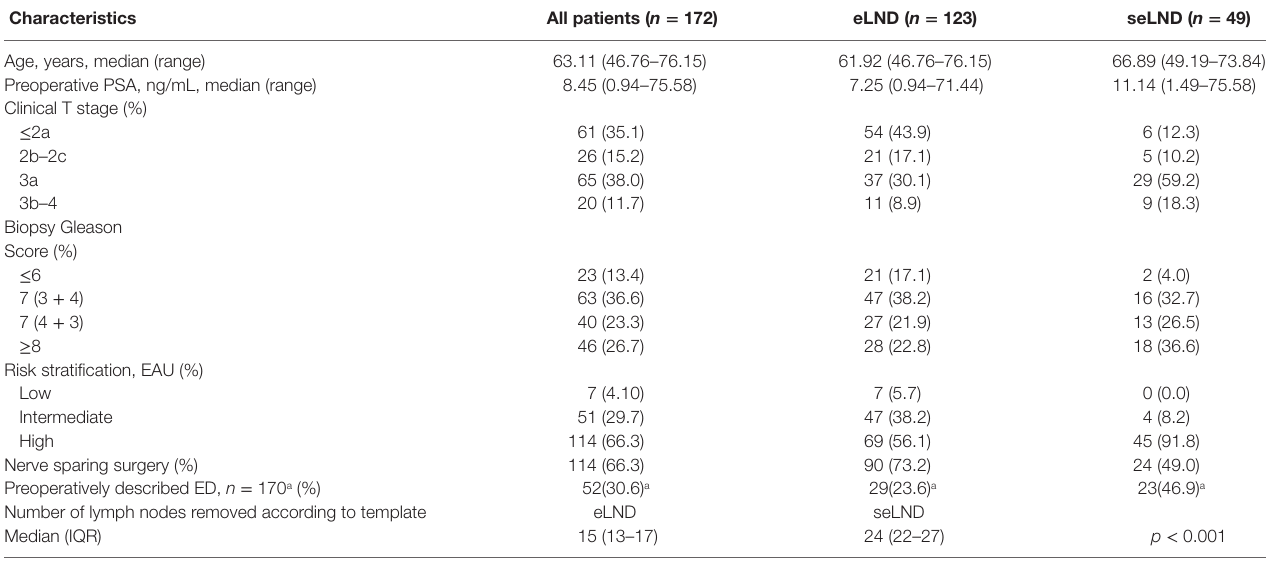
TaBle 1 | Patient and disease characteristics of the study